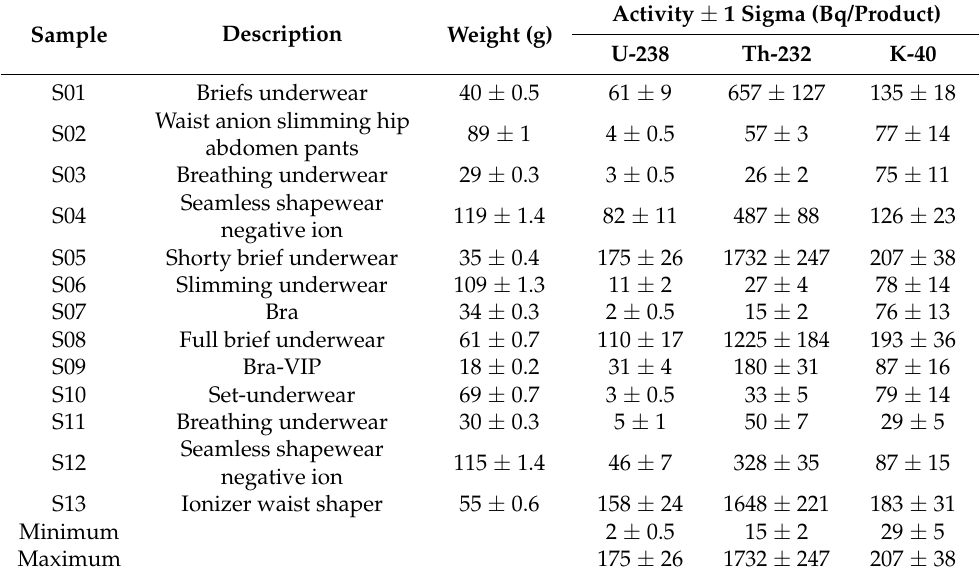
Table 1. Activity (Bq/product) of 238 U, 232 Th, and 40 K for undergarments.